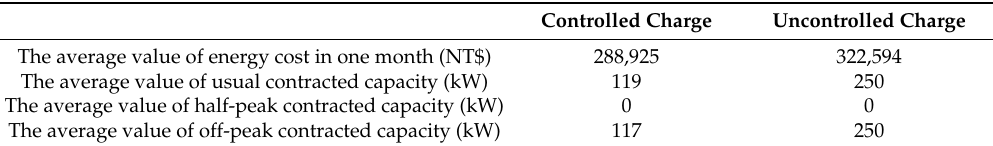
Table 3. Controlled charge and uncontrolled charge planning results for 1000 iterations.